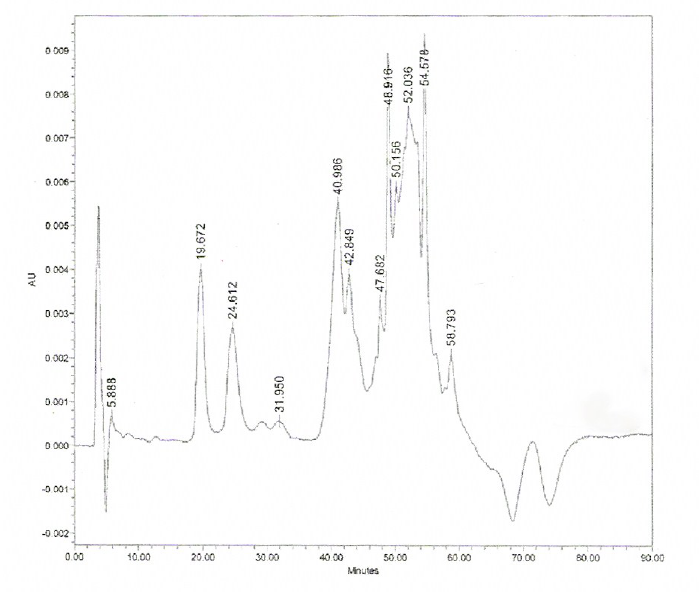
Figure 2. HPLC chromatogram of Eleusine coracona extract in gradient elution with one mg.mL -1